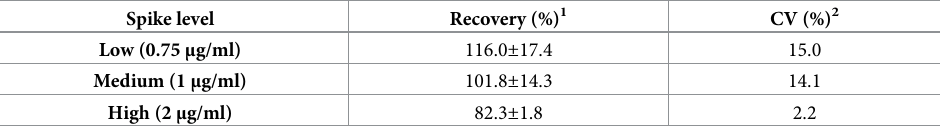
Table 4. Recovery analysis of normal human sera supplemented with hexameric ZNS1 by 1F5 based-indirect com- petitive